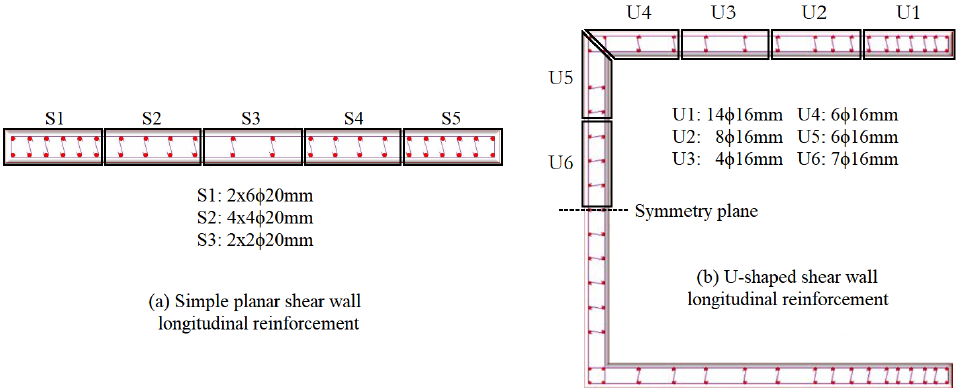
Figure 9. Shear walls longitudinal reinforcements [3],